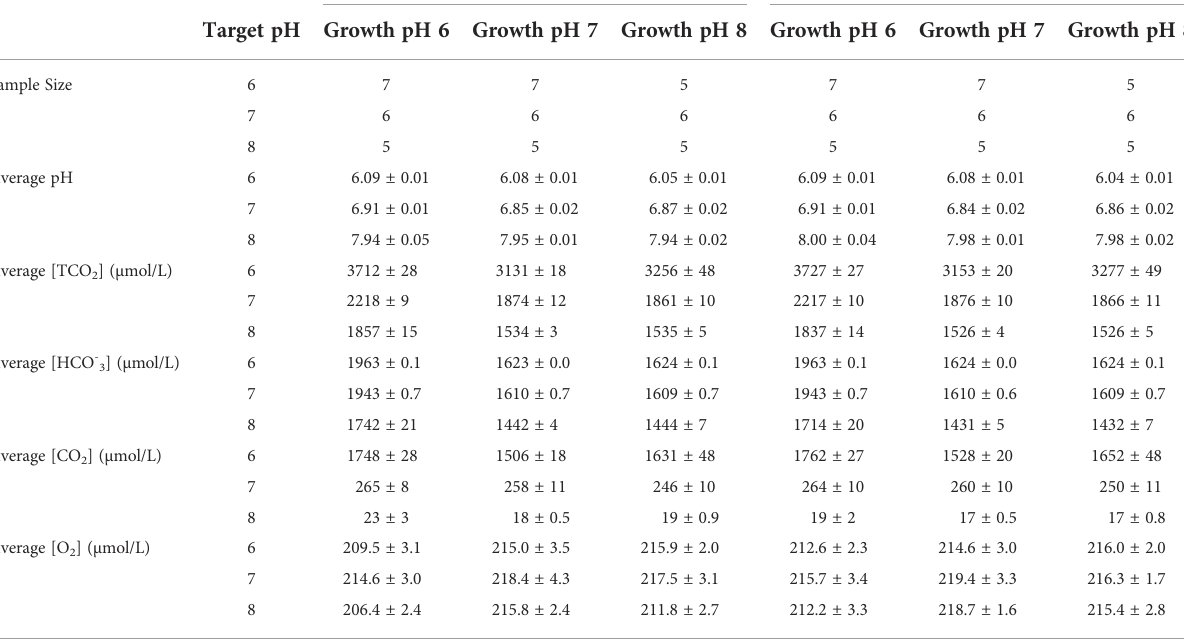
TABLE 2 Distribution of dissolved inorganic carbon and dissolved oxygen concentrations in seawater during the incubation measurements of net photosynthesis at different light levels, including dark respiration measurements. At the start of light measurements At the start of dark